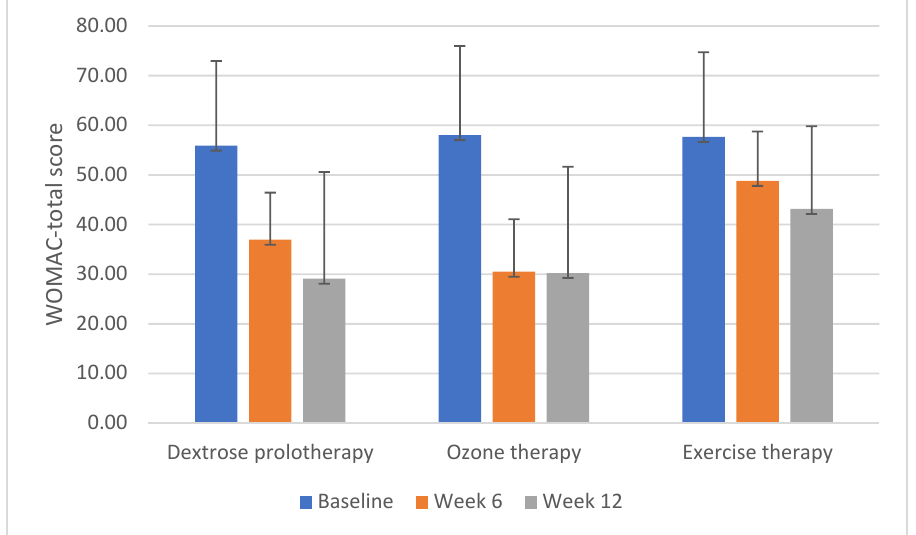
Figure 4. WOMAC-total scores in dextrose prolotherapy, ozone therapy, and home-based exercise therapy groups.